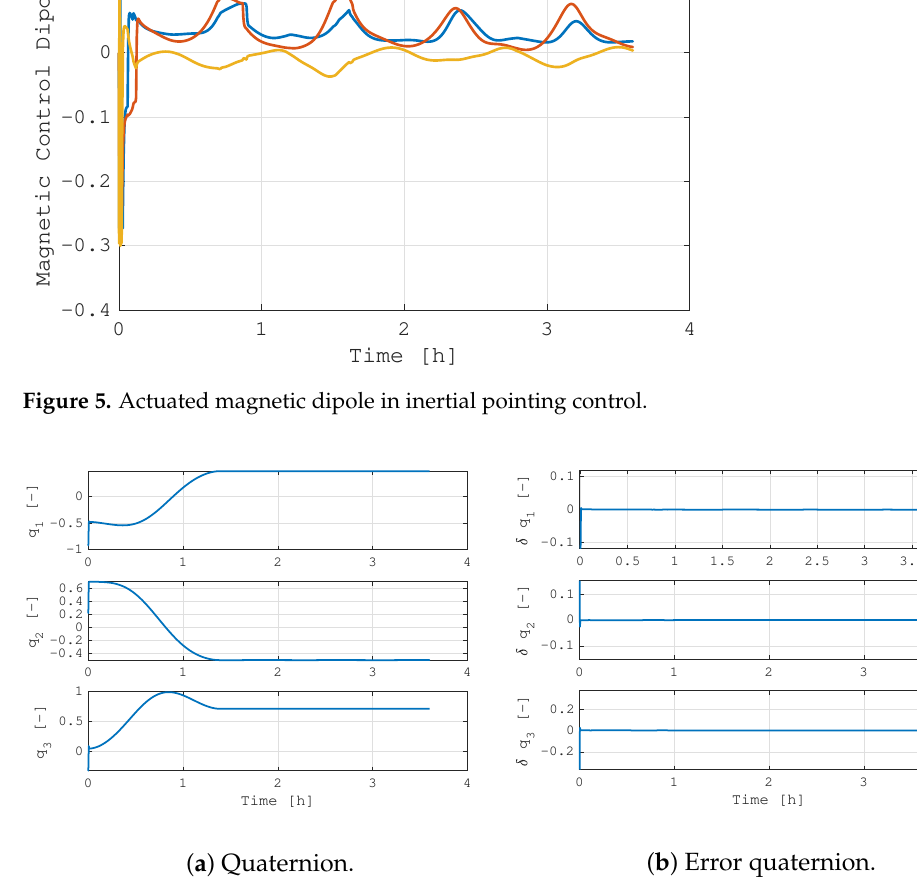
Figure 6. Reference attitude tracking